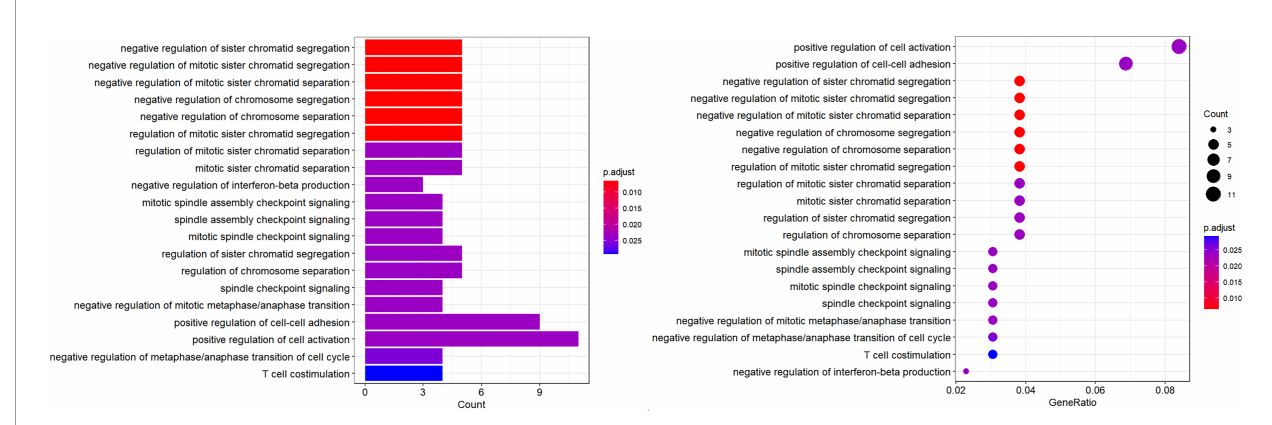
FIGURE 9 | GO functional enrichment of the differential